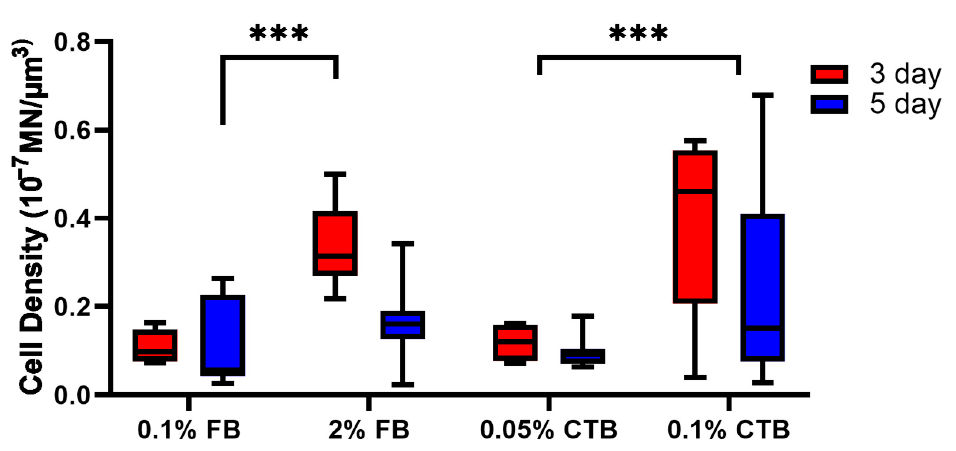
Figure 8. Density of labeled α -MNs in aged mice (25 months) among tracer protocols. α -MN density was measured as the number of labeled MNs per unit tissue volume from 3D z-stack images for all experimental groups. The number of cells analyzed per group (from left to right in order) is 8, 7, 8, 13, 4, 7, 8, and 14. Data are median ± 95% confidence interval. *** denotes p < 0.001.